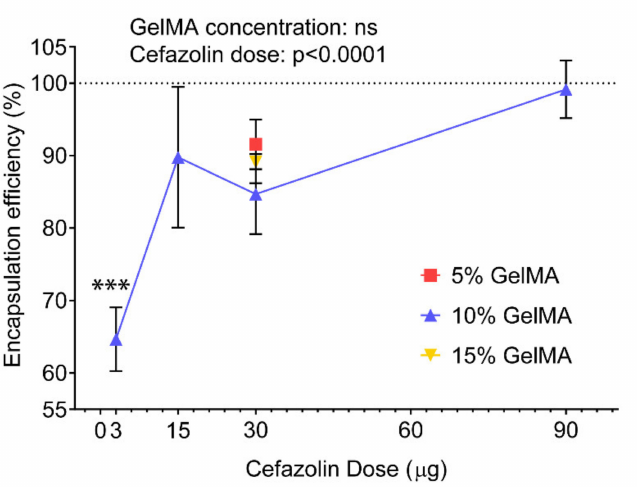
Figure 1. Encapsulation efficiencies of cefazolin in 5%, 10%, and 15% gelatin methacryloyl (GelMA) hydrogels prepared by blend-loading. Results are shown as mean ± standard deviation, n = 6. *** p < 0.001 compared to all other